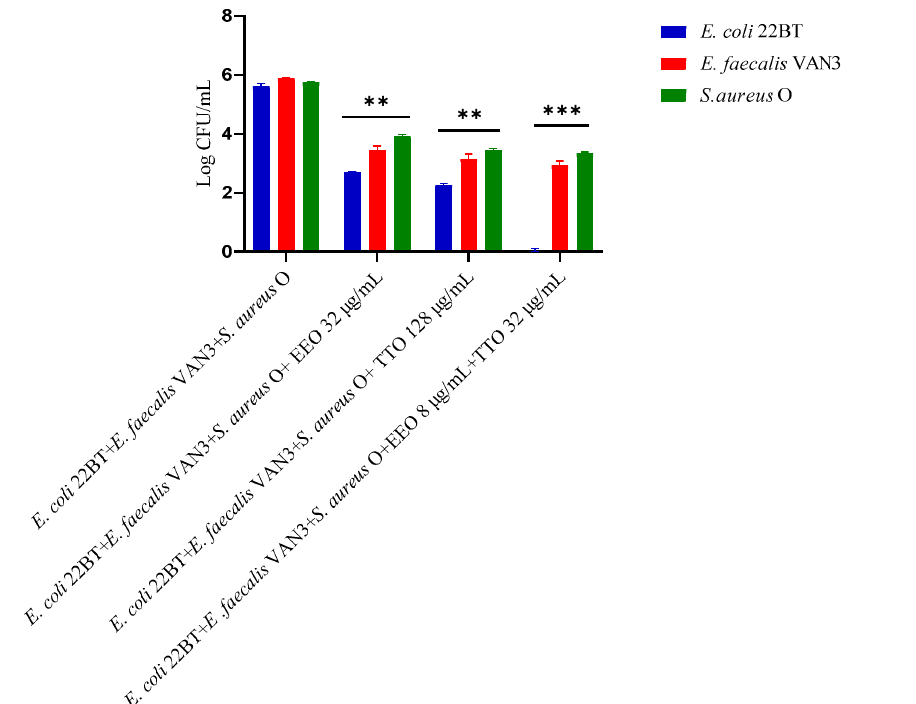
Figure 7. Quantification of viable cells in multi-species mature biofilm using Melaleuca alternifolia (TTO), Eucalyptus globulus (EEO) EOs and the association EEO/TTO. Results were expressed in Log CFU/mL as the arithmetic mean of the three determinations. p -values of <0.05 (*), p < 0.01 (**), p < 0.001 (***) and p < 0.0001 (****) were considered significant by ANOVA test.